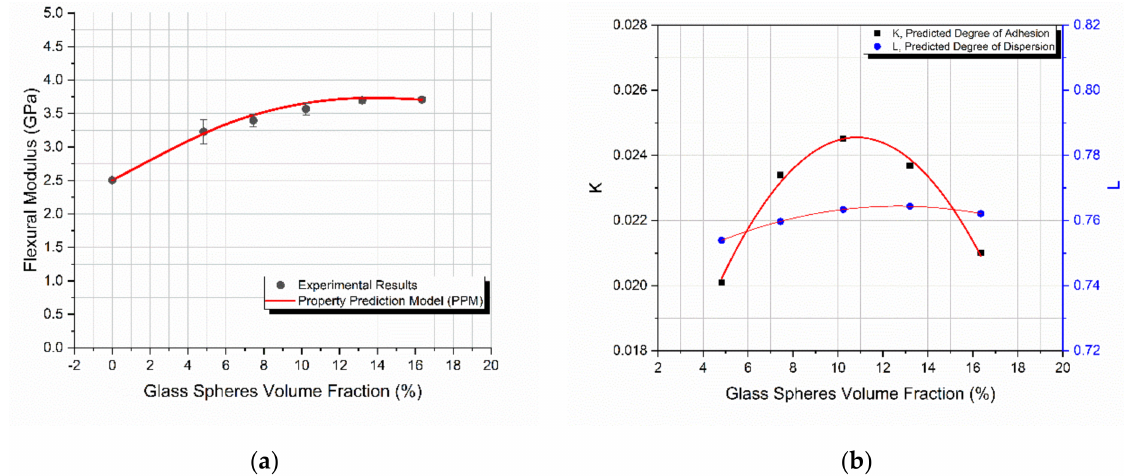
Figure 2. Glass spheres starch-epoxy composites variation with the filler-volume fraction V f , of ( a ) flexural modulus experimental and predicted values, ( b ) degree of adhesion K , and degree of dispersion L predicted